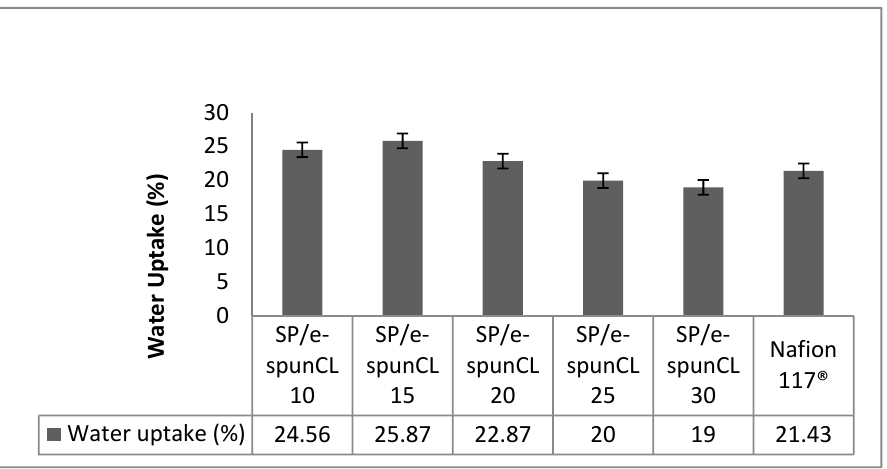
Figure 4. Water uptake of all SP/e-spunCL membranes and Nafion 117 ® .